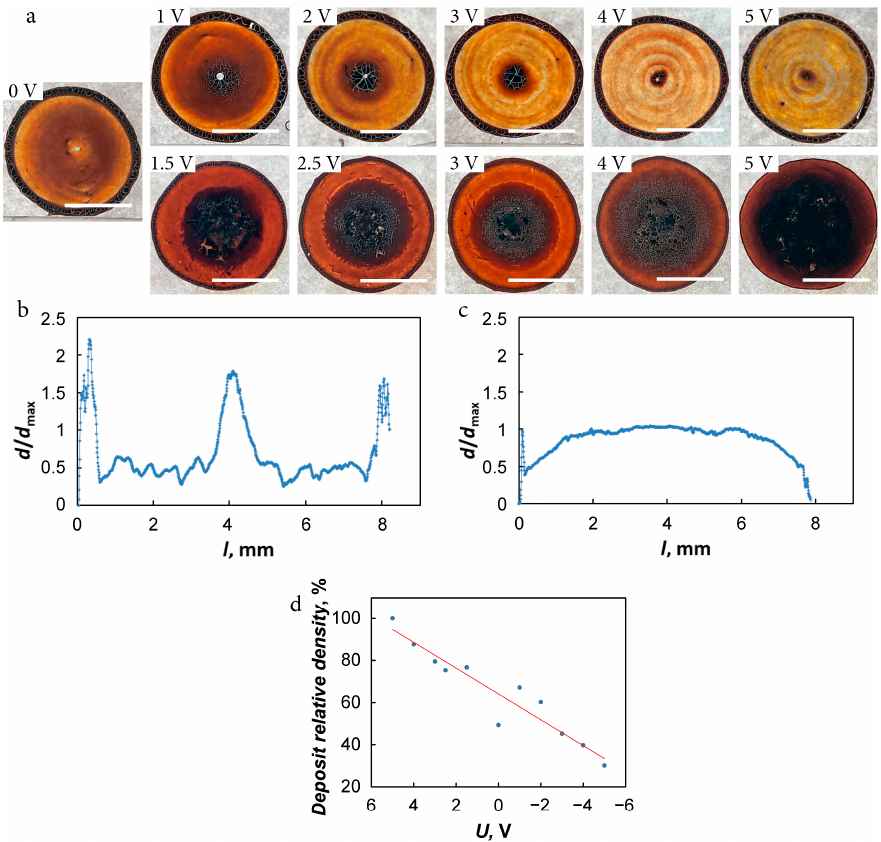
Figure 4. The architecture of the deposits formed during the evaporation of droplets of sample No. 1 under an applied electric field. The visual appearance of the deposits. Top line: a positive potential of the substrate and negative at the needle electrode; bottom line: negative substrate, positive needle electrode. Scale bars are 4 mm ( a ); relative thickness profiles of precipitates formed during the evaporation of a droplet on a glass substrate under the influence of an electric field with a negative ( b ) or positive ( c ) potential on a needle electrode. The potential difference between the electrodes U = 5 V; relative density of the deposit except for the outer ring ( d ), blue circles—experiment data, red line - linear approximation.